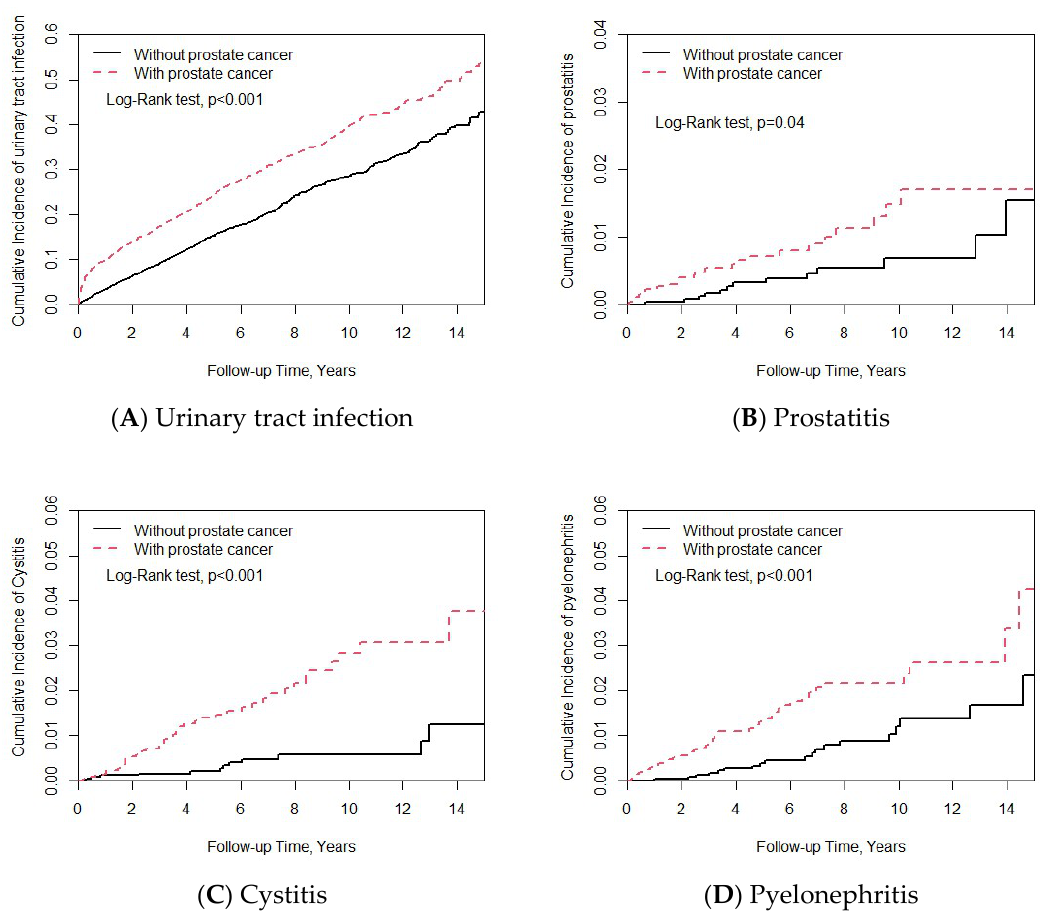
Figure 1. Cumulative incidence of ( A ) urinary tract infections, ( B ) prostatitis, ( C ) cystitis, and ( D ) pyelonephritis between the patients with and without prostate cancer. Table 4. Comparisons of the incidence of urinary tract infections between the patients with and without prostate cancer according to baseline characteristics and follow-up